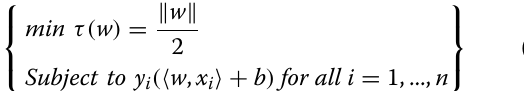
The problem is converted to finding the optimal hyper- plane (Eq. 1), which can be turned into a convex